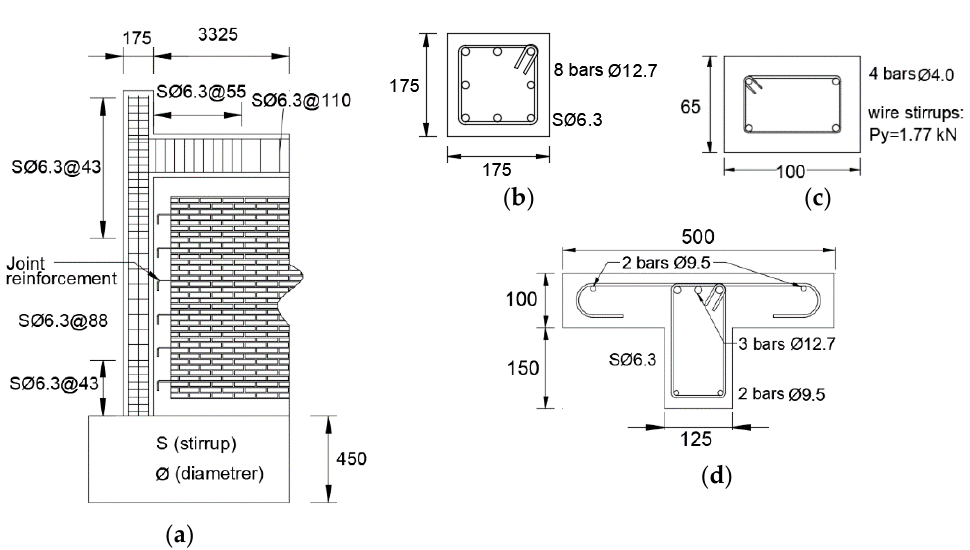
Figure 3. Dimensions (in millimeters) and reinforcing details of specimens. ( a ) elevation view, ( b ) columns, ( c ) tie-columns and tie-beams, ( d ) beams.